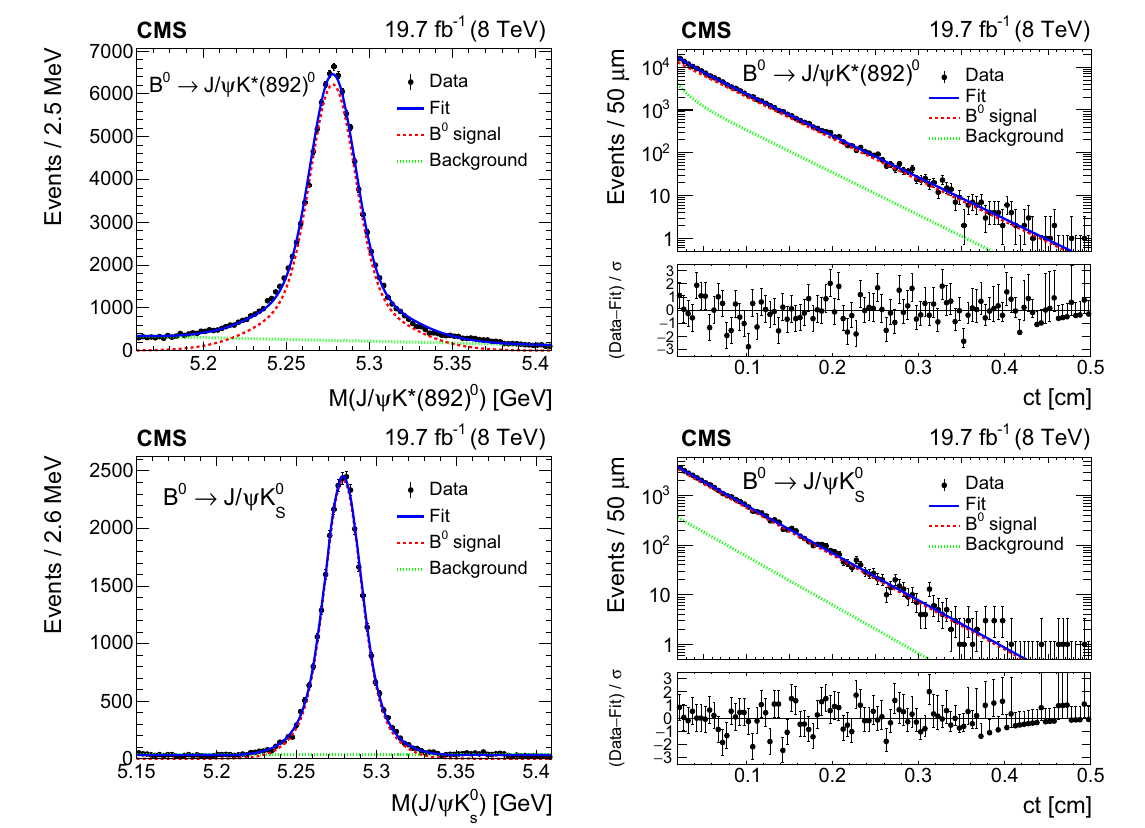
Fig. 3 Invariant mass (left) and ct (right) distributions for B 0 can- didates reconstructed from J /ψ K ∗ ( 892 ) 0 (upper) and J /ψ K 0 decays. The curves are projections of the fit to the data, with the con- tributions from signal (dashed), background (dotted), and the sum of